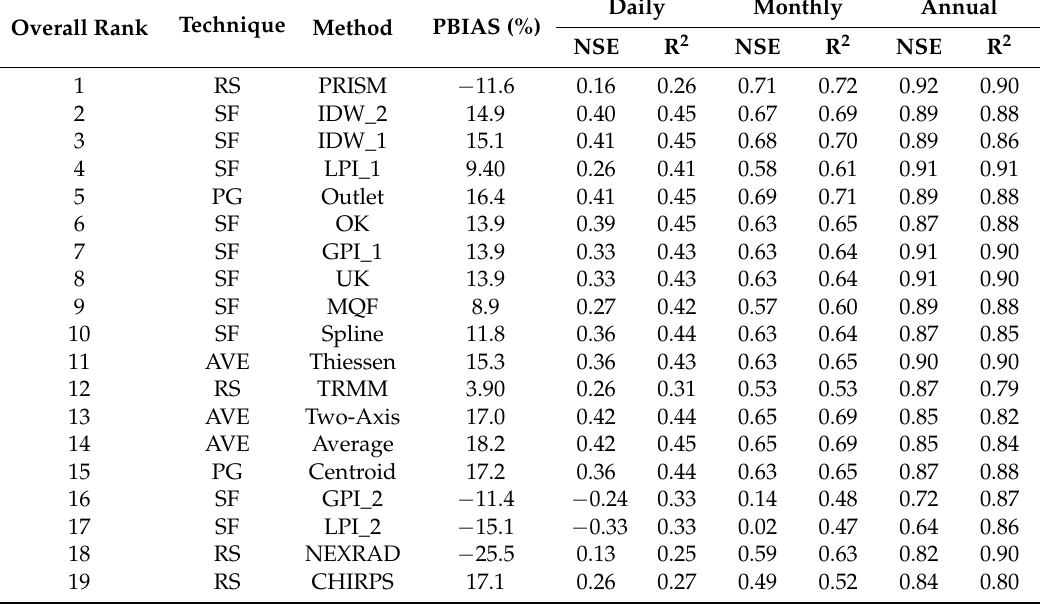
Table 7. Mean areal precipitation (MAP) input effects on the uncalibrated SWAT model performance results and ratings at daily, monthly, and annual time steps after the SWAT model calibration in the Hinkson Creek Watershed, Missouri, USA. SWAT models were forced with 19 different precipitation methods. MAP methods are presented by the overall model performance rank (i.e., high to low